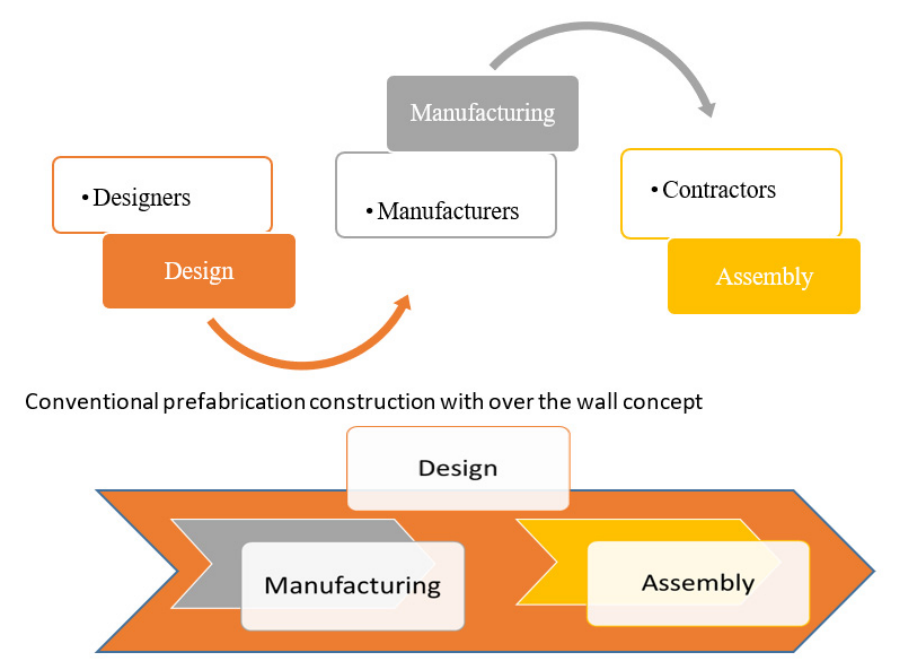
Figure 1. Simplified DfMA principles.